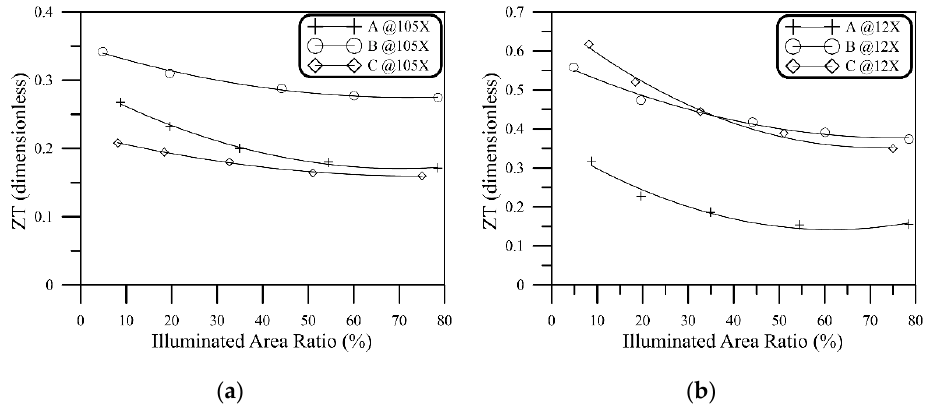
Figure 8. ZT as a function of the illumination area percentage for the three TEG samples under light intensity of ( a ) 105 × and ( b ) 12 × .